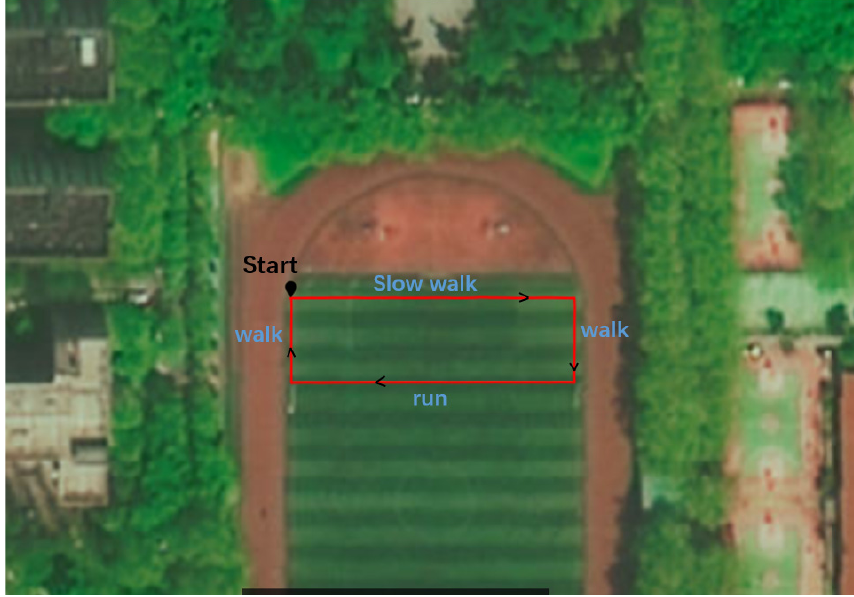
Figure 7. The experiment environment.